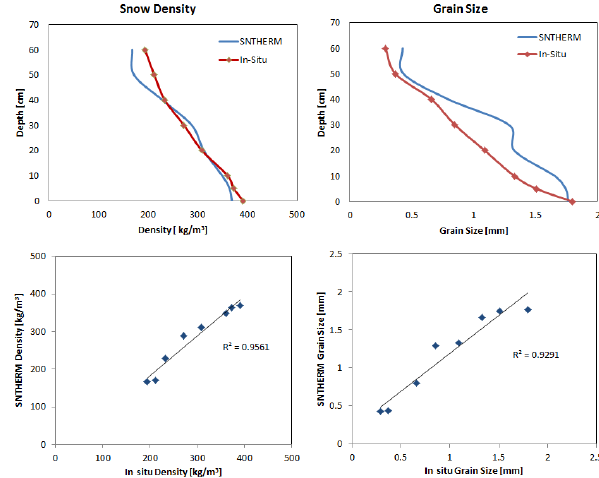
Fig. 8. Validation of SNTHERM simulated snow grain size and den- sity using measured snow grain size and density from snow pit data taken on DOY